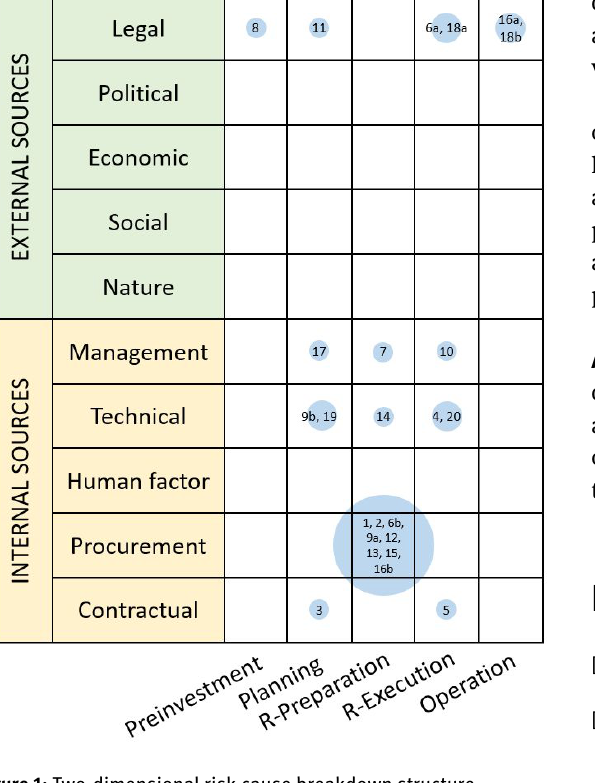
ity and/or differences in the individual risk causes, these were classified as internal and/or external risk sources as described above. The highest risk identified was the pro- curement risk (33.3%) which belongs to the internal risk category. The second most frequently represented risk was the legal risk (25.0%), which belongs to the external risk category and subsequently the technical risk (20.8%), one of the internal risks. While procurement risk